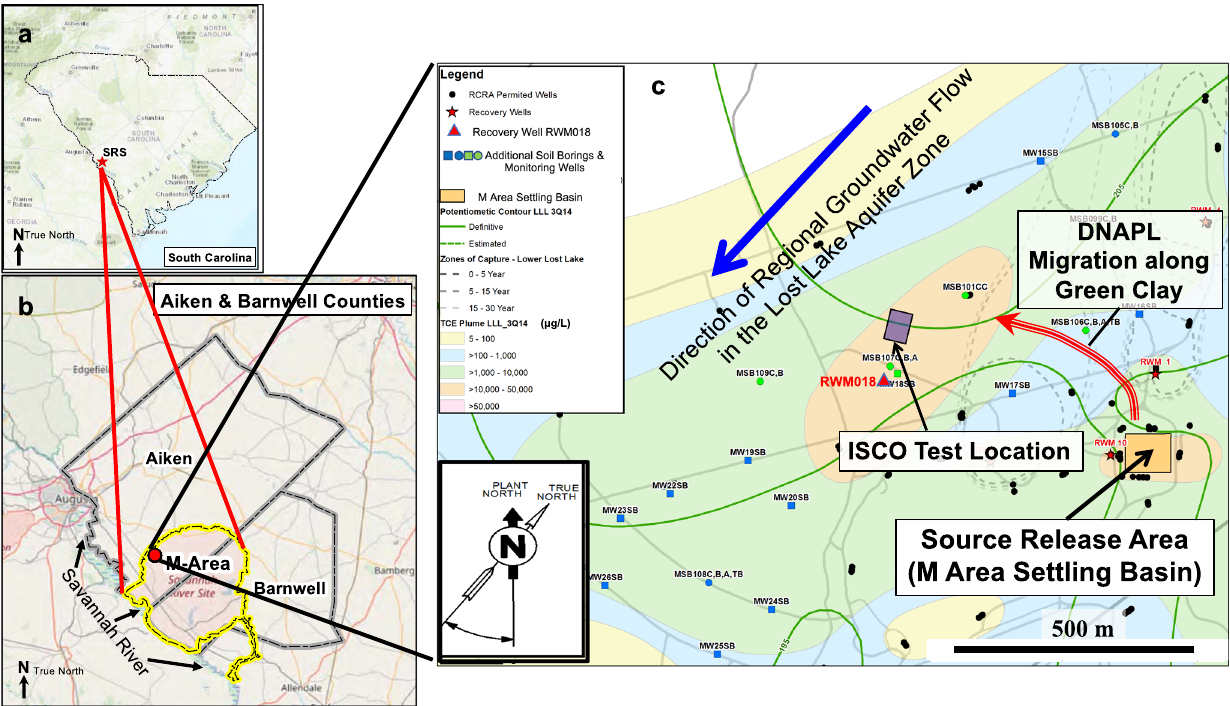
Fig. 1 Location of the SRS and the In Situ Chemical Oxidation (ISCO) test site 60 . a Location of SRS in South Carolina, United States. b SRS bounded in yellow with M Area location (red circle) highlighted. The Savannah River and surrounding counties including Aiken and Barnwell are marked. c M Area lost lake aquifer zone TCE plume showing groundwater fl ow direction and the hypothesized DNAPL fl ow path. Red stars indicate the locations of recovery wells (RWM) used in the groundwater containment and recovery system in the area. Blue and green squares show soil boring locations, while blue, green, and black circles show monitoring well locations. The yellow, blue, green, light pink, and pink shades indicate TCE concentrations from 5 – 100, >100 – 1000, >1000 – 10,000, >10,000 – 50,000, and >50,000 µ g l − 1 , respectively. The red arrow indicates a possible DNAPL migration path based on density driven transport along fi ne-grain geologic strata. The location of the ISCO test site is also shown as a purple rectangle. The red triangle shows the location of recovery well RWM 018 that controls groundwater fl ow in the ISCO test area. Please note that panel c is oriented to Plant North in the SRS coordinate system rather than True North as shown in the legend.